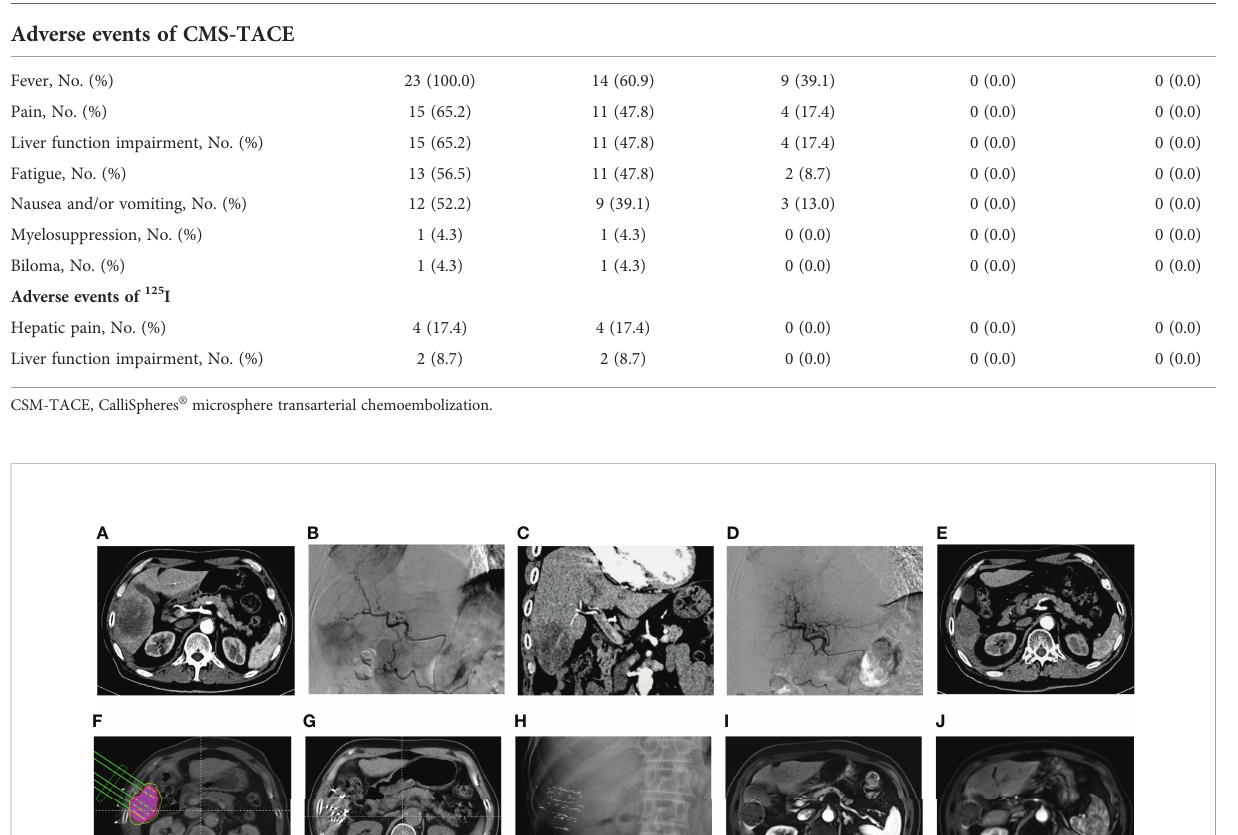
(Figure 2D). One month after the third round of CSM-TACE,